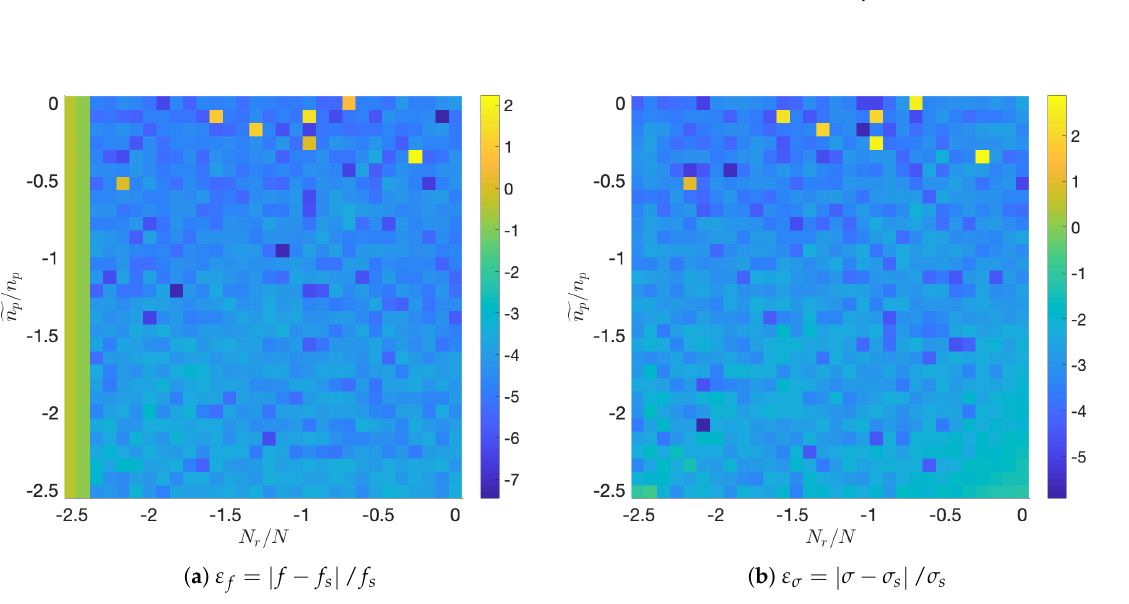
Figure 2. Synthetic system: Relative errors in frequency ( a ) and growth rate ( b ) with uniform temporal compression N r / N < 1 and spatial reduction (cid:102) n p / n p < 1 using K-means algorithm, in a log 10